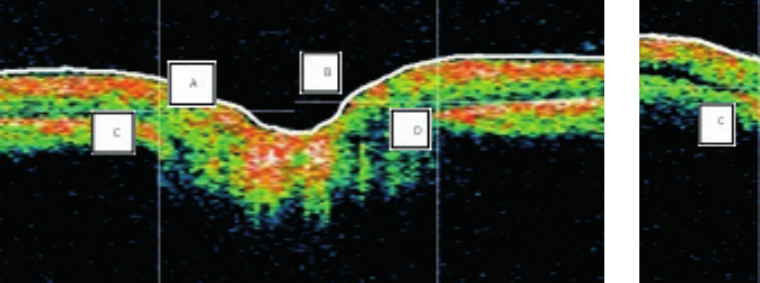
Fig. 5. OCT image of Normal subject (CDR =0.33779). Fig. 6. OCT image of a subject affected by glaucoma (CDR